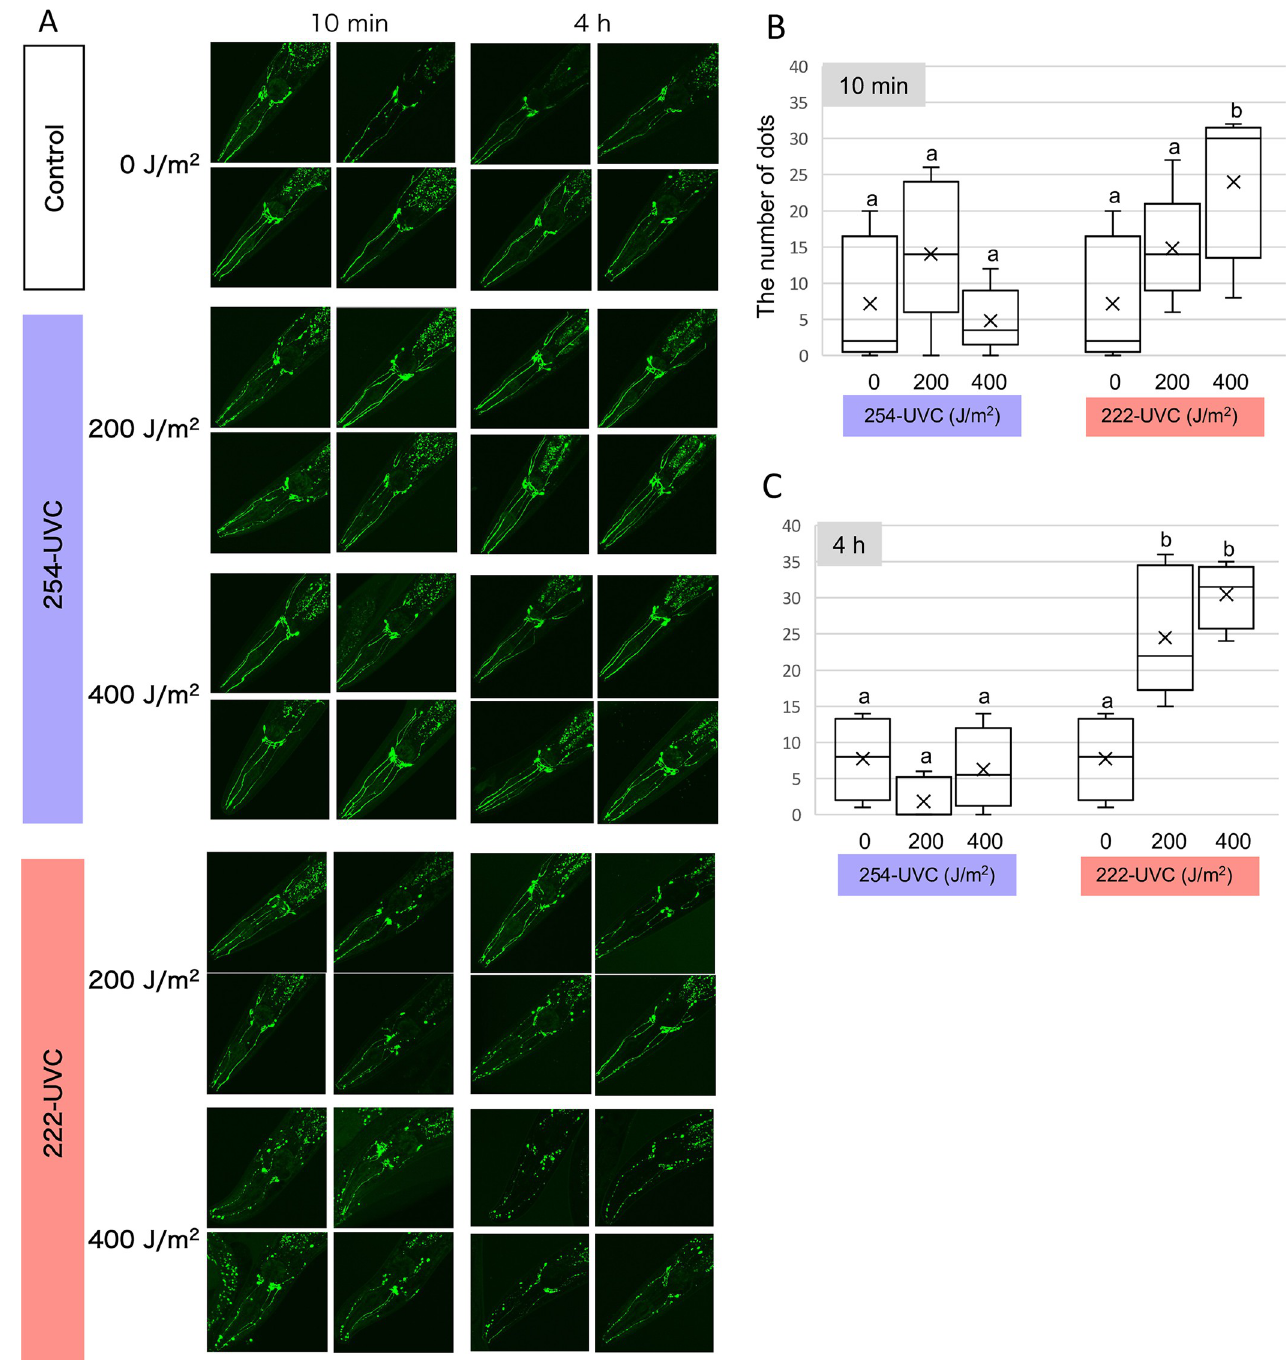
Fig 5. Dopaminergic neurons degenerate upon UVC exposure. (A) Representation of damage in dopaminergic neurons after UVC exposure. 3D reconstruction of confocal fluorescence from head dopamine neurons in a p dat-1 ::GFP transgenic line (TG2435). GFP-labeled dopaminergic neurons were observed 10 min and 4 h after 254-and 222-UVC exposure (200 and 400 J/m 2 ). (B and C) The number of GFP dots along CEP dendrites in the head zone. GFP dots were counted by looking with adding the mark on the pictures opened by ImageJ software. Box plots show minimum, 25th percentile, median, 75th percentile, and maximum. Inside line and x indicate the value of median and average, respectively. a and b indicate a significant difference between indicating two groups (one-way ANOVA followed by Dunnett’s method) ( P < 0.05).